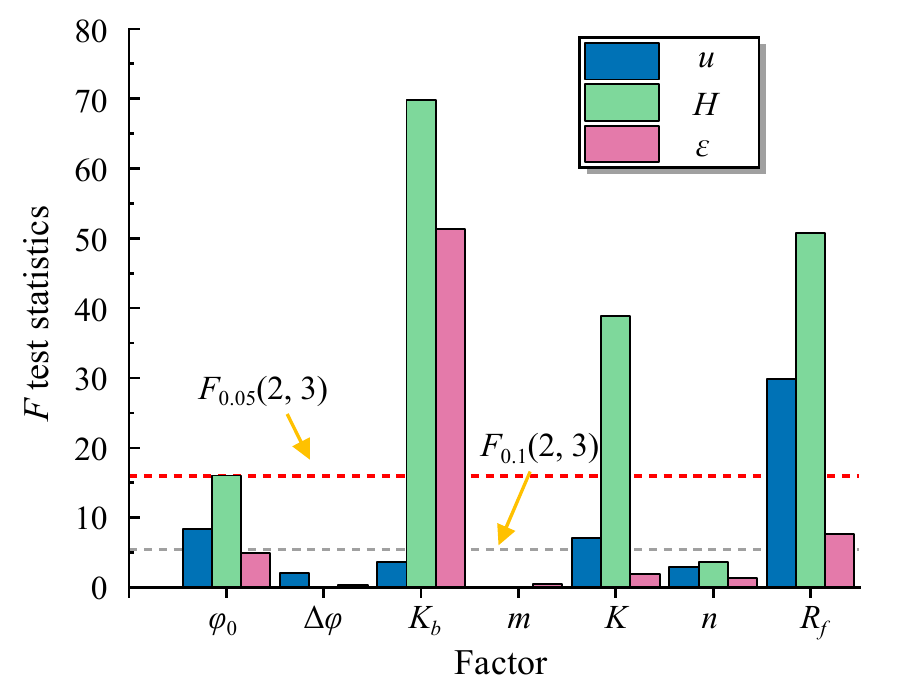
Figure 11. ANOVA results of each parameter in the main rockfill zone to different indexes. Table 12. ANOVA results of influencing factors of each test index for the secondary rockfill